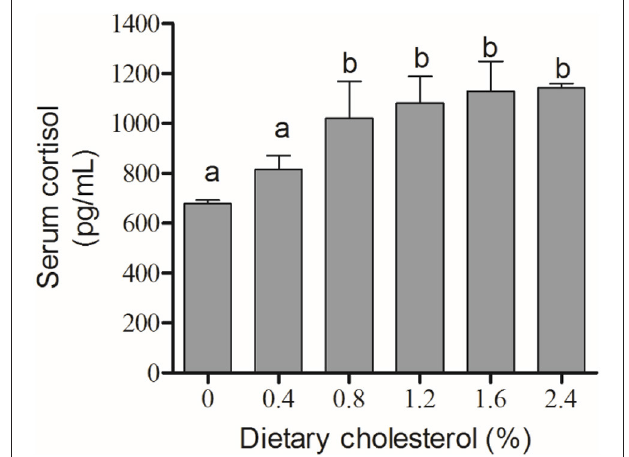
FIGURE 4 | The content of cortisol in the serum. The abscissa indicates the diets, with the different cholesterol percentages labeled 0, 0.4, 0.8, 1.2, 1.6, and 2.4%. The ordinate represents the content of cortisol, and the units are pg/mL. The different lowercase letters represent significant differences among groups ( P < 0.05). Values (mean ± S.E.) of the cortisol content in the serum are the mean of nine